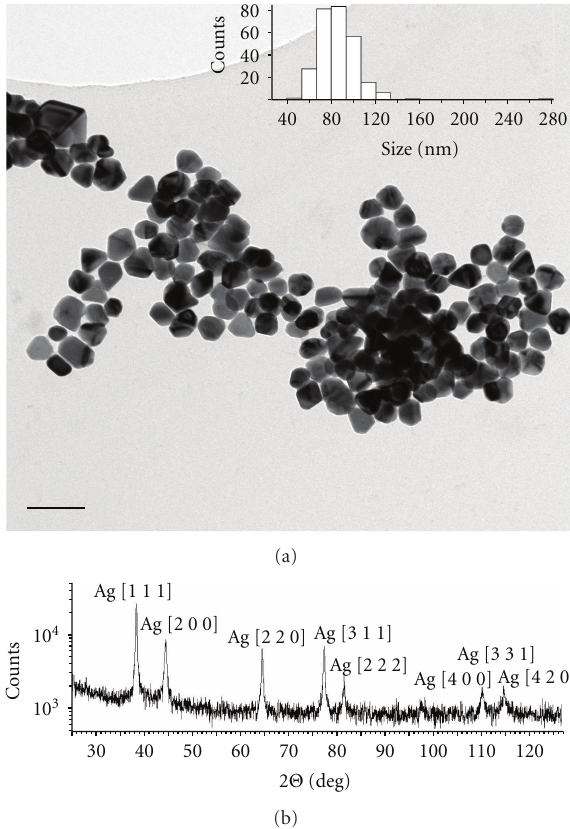
Figure 1: (a) Representative TEM image of stock nanosilver sus- pension along with size statistics (insert). (b) PXRD pattern for the nanosilver powder with the indexed di ff raction lines of silver.